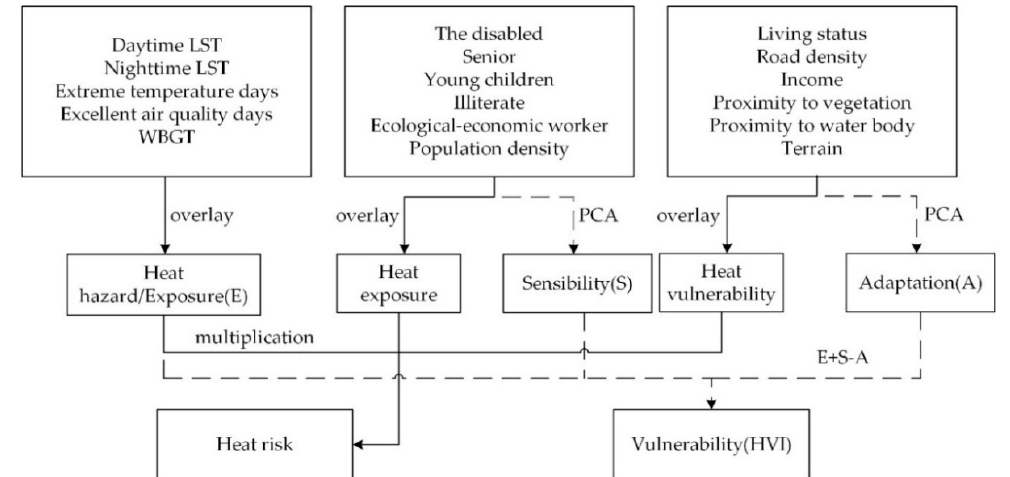
Figure 3. A detailed flowchart of spatial risk assessment methodology.